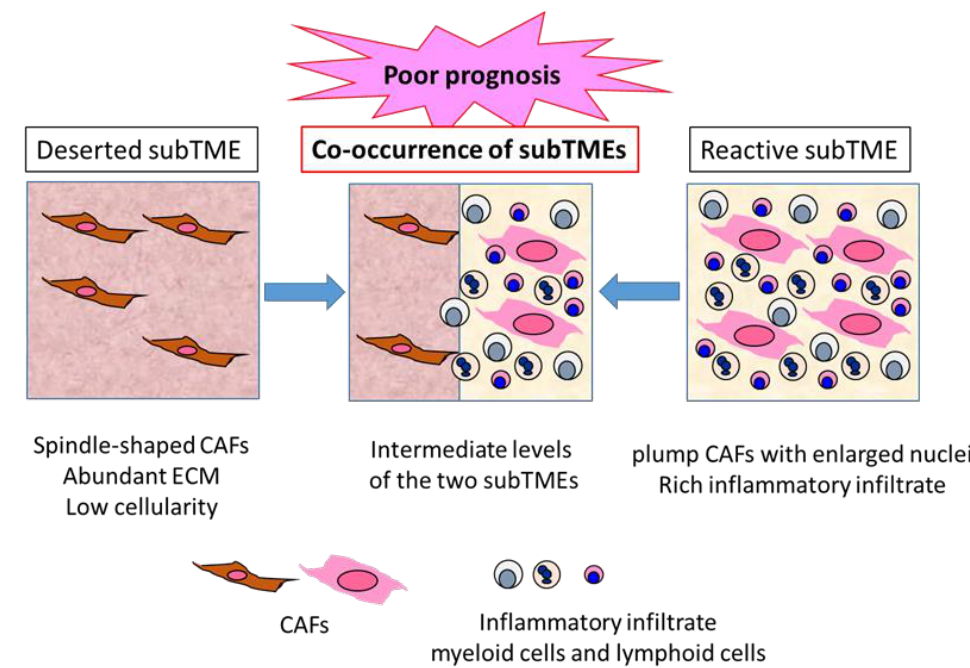
Figure 2. Three types of PDAC subTME and prognoses. PDAC TME can be divided into characteristic subTME, which is the sum of various components in the TME, with distinct gene and protein expression profiles. Deserted subTME contains spindle-type CAFs and abundant ECM, with low cellularity. Reactive subTME contains plump CAFs, with enlarged nuclei and rich inflammatory infiltrate. Co-occurrence of the two distinct subTMEs is frequently observed in the same PDAC tumor, indicating a poor prognosis compared to the tumors containing one major subTME.